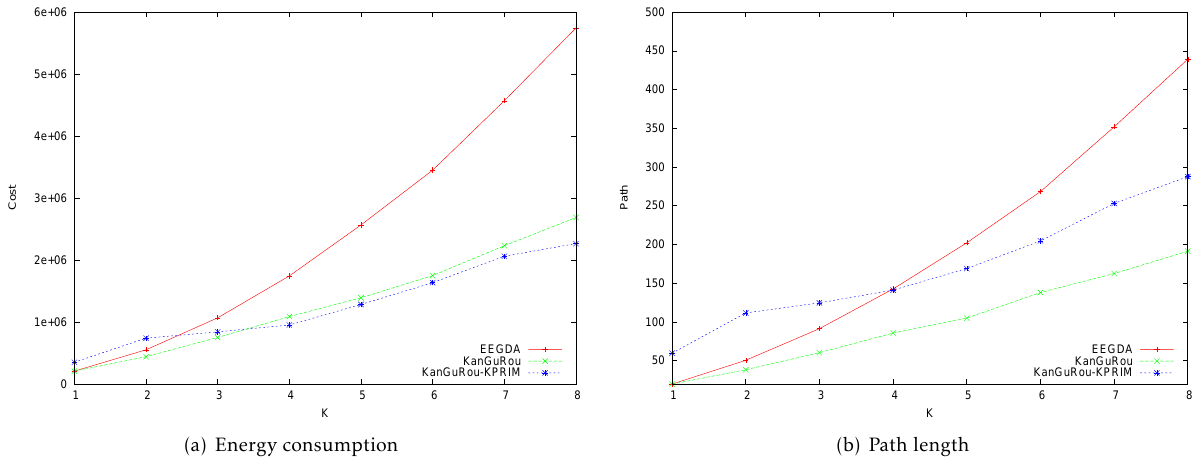
Figure 6. Algorithms performance in terms of k over M = 8 sinks among N = 75 nodes.